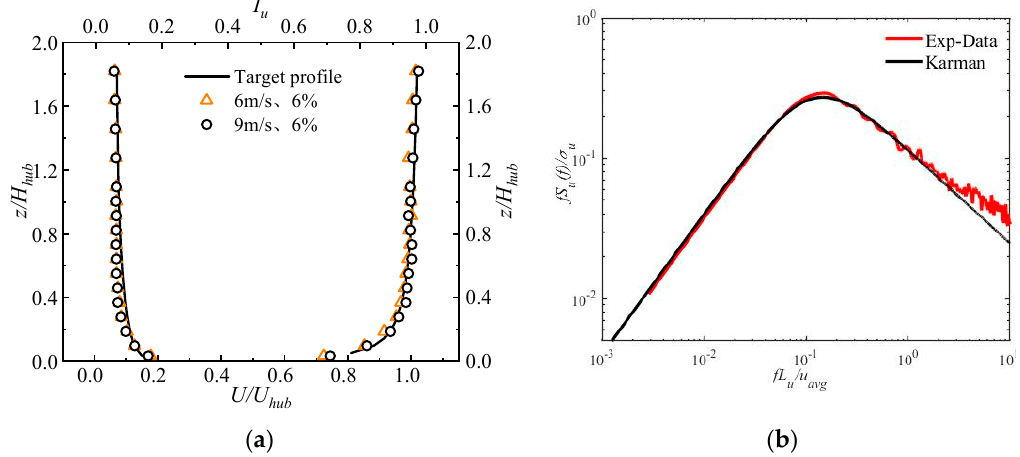
Figure 2. Upstream atmospheric boundary layer flows simulated in the wind tunnel tests: ( a ) vertical profiles of normalized mean wind velocity; ( b ) wind velocity spectrum of U hub = 6 m/s.